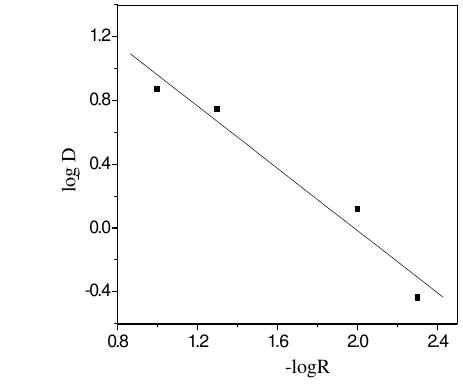
Figure 7 . Plot of log D versus log [Tz + .Cl - ] of bismuth(III) extraction from aqueous KI medi at pH 1.2 into the organic phase.